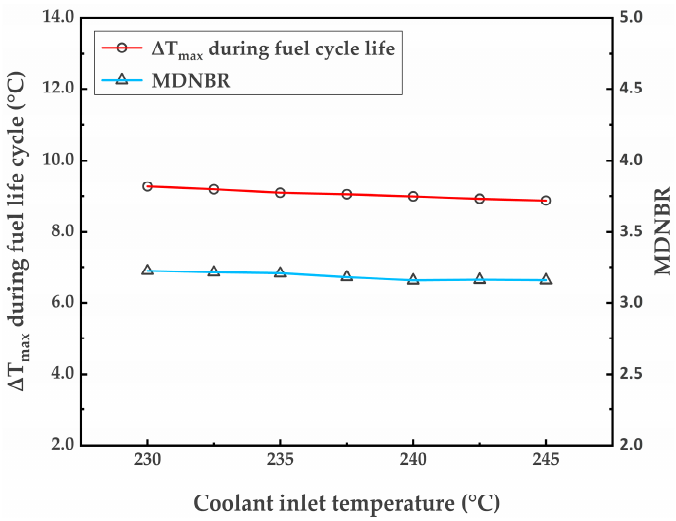
Figure 7. Optimization results under different assembly inlet temperatures.